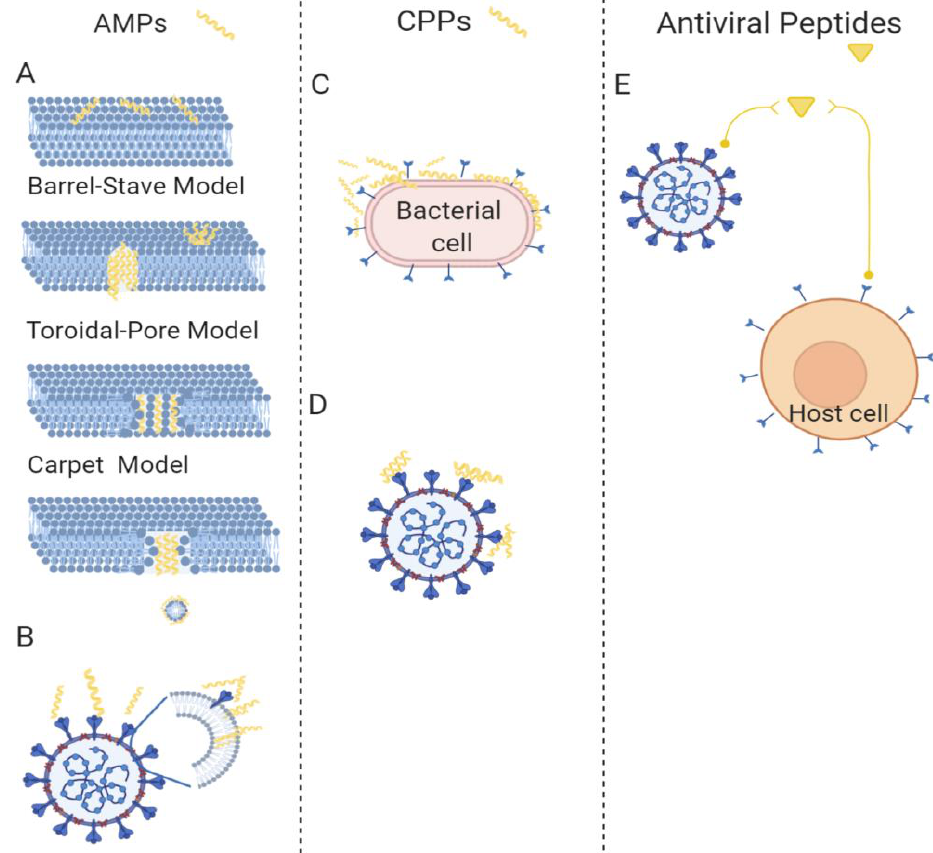
Figure 3. The main classes of peptides showing antibacterial and antiviral activity. ( A ) The mechanisms of antibacterial activity proposed for AMPs (barrel-stave, toroidal-pore, and carpet). ( B ) The hypothesized antiviral mechanisms for AMPs, which involve inhibition of viruses integrating in either the viral envelope or the host cell membrane. ( C ) The antibacterial mechanism proposed for CPPs, which involves local disruption of bacterial membrane bilayers. ( D ) The antiviral mechanism of CPPs, involving the formation of inactive aggregates between the fusogenic stretches present in the viral protein and the host cell. ( E ) The mechanism of antiviral peptides, involving inhibition of viral attachment and penetration. Created with BioRender.com.